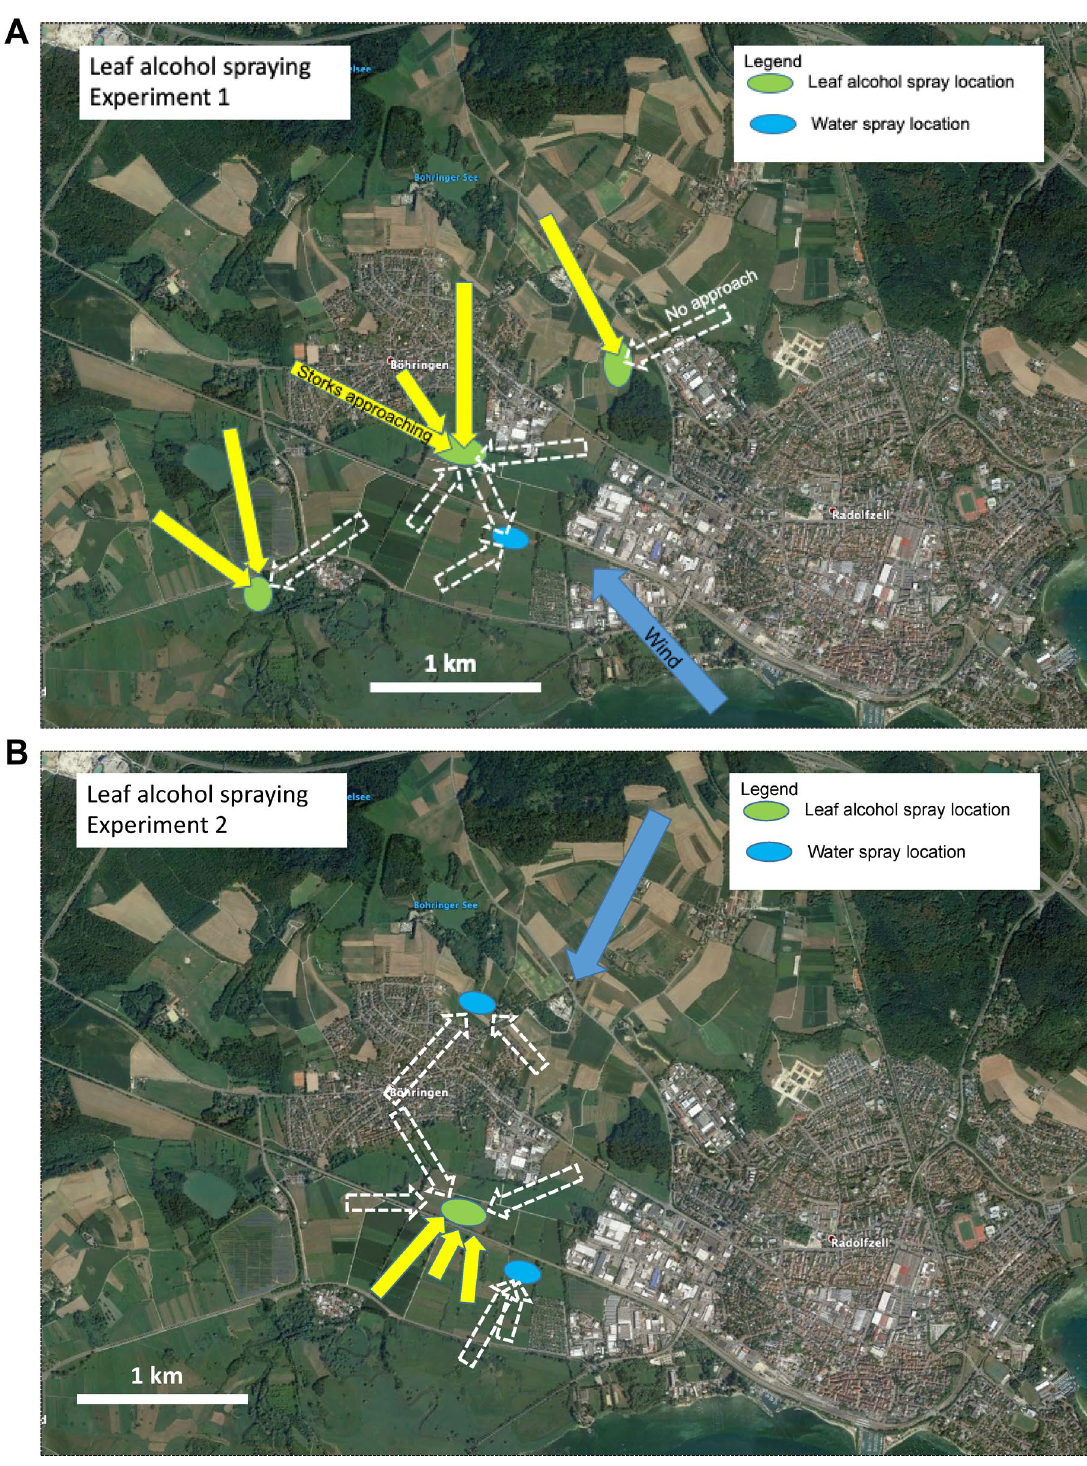
Figure 4. Storks immediately approached an aerially-sprayed volatile organic compound mix. ( A ) and ( B ) Maps of the area around Böhringen, Germany, showing the locations of water spraying (blue area), leaf alcohol spraying (green areas), the downwind approach locations and distances by independently approaching storks (yellow arrows), and upwind areas where storks resided in fields, but did not approach (white stippled arrows). ( A ) Experiment conducted on 27-04-2018, ( B ) Experiment conducted on 02-07-2018. ( C ) Comparison of approach reactions of storks towards water and leaf alcohol. Chemical structures of the three leaf alcohols are indicated above the black bar. The difference between the treatments is highly significant (X 2 = 11.7, N = 15, df = 2, p = 0.003). Maps were created from Google